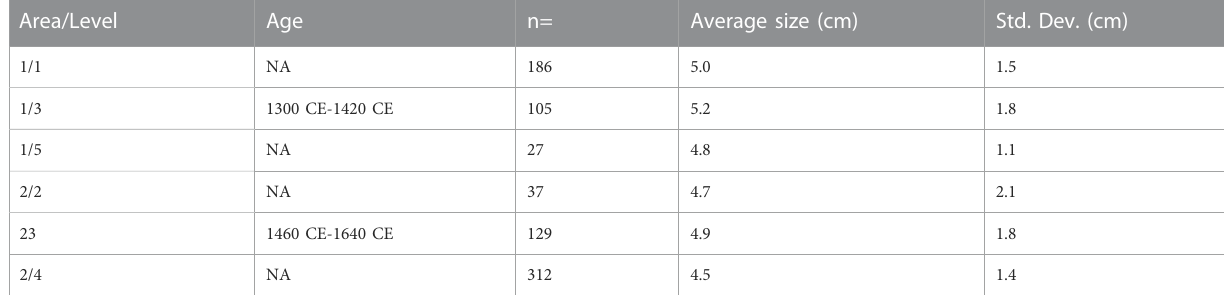
TABLE 6 Average size of mussel from Area 1 and 2 at CA-SMA-216.